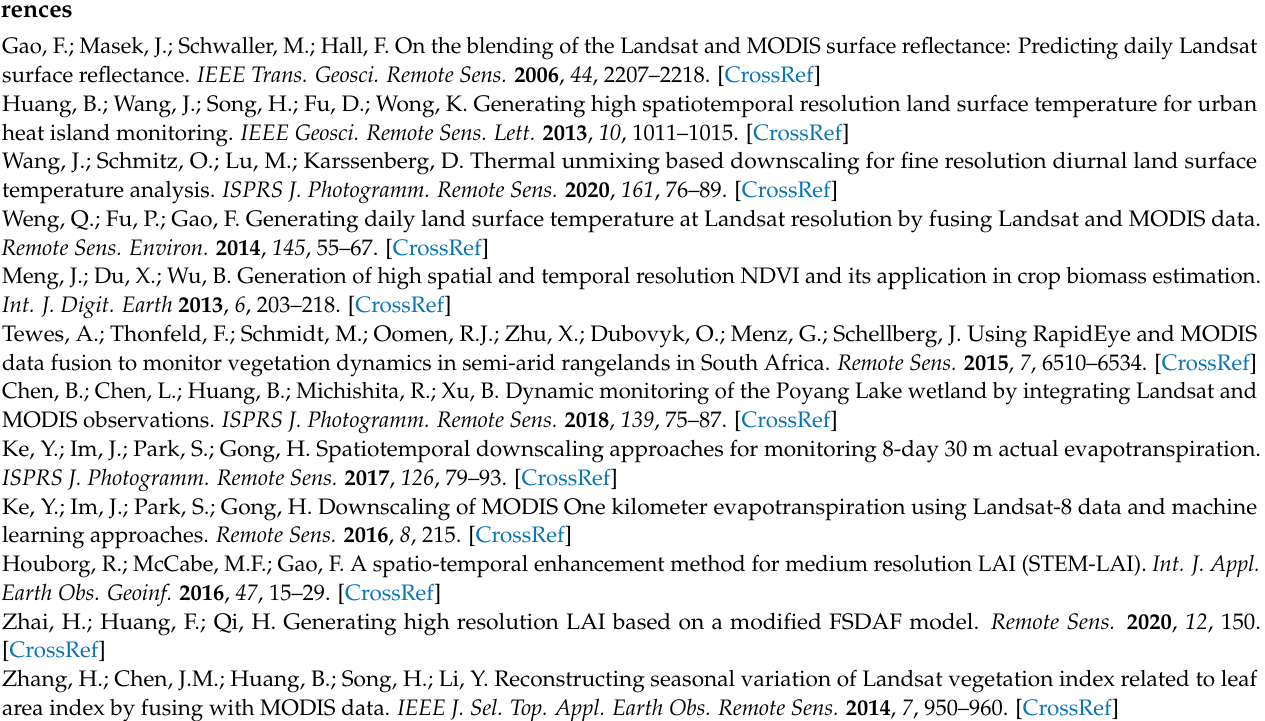
Table S2: Comparison of the root mean square error (RMSE) results of MODIS NDVI and Landsat NDVI after correction by four regression